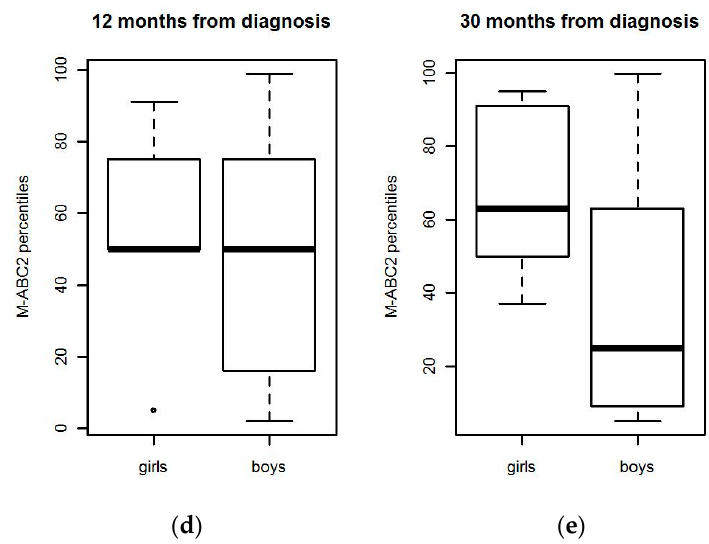
Figure 4. Motor performance scores for boys and girls in ( a ) 0, ( b ) 2, ( c ) 6, ( d ) 12, and ( e ) 30 months.